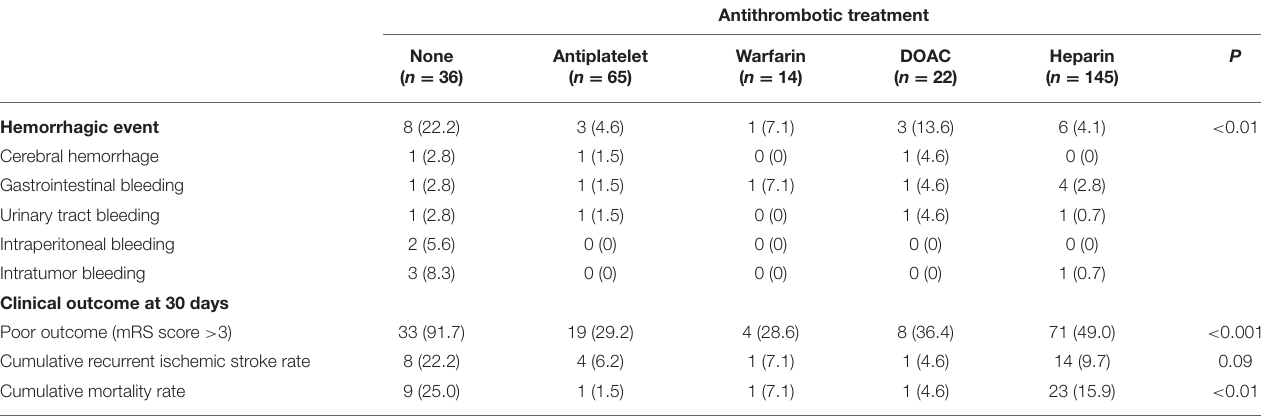
TABLE 5 | Rates of hemorrhagic events within 30 days after admission and clinical outcomes in each antithrombotic treatment group. Antithrombotic treatment None